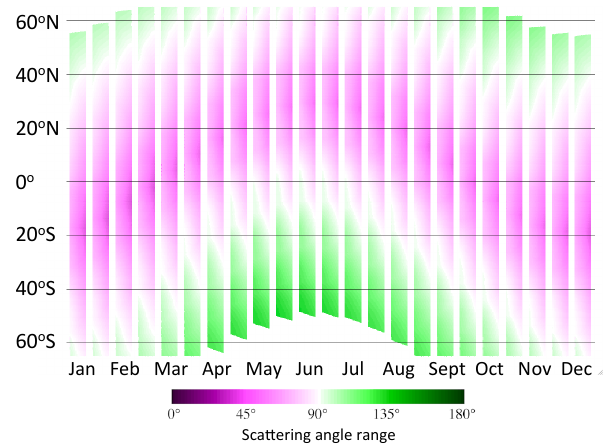
Fig. 6. Scattering angle range ( 2 max − 2 min ) sampled considering all nine MISR cameras, displayed as a function of latitude and time of